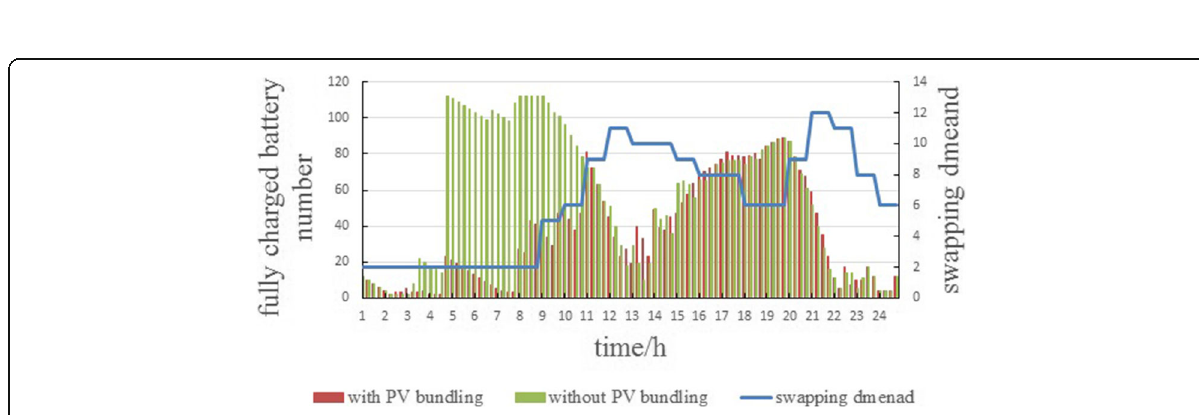
Fig. 8 EV battery redundancy curves with and without PV bundling requirements at a workday in the